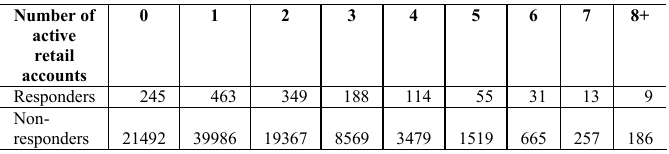
Table 2: Counts of responders and non-responders